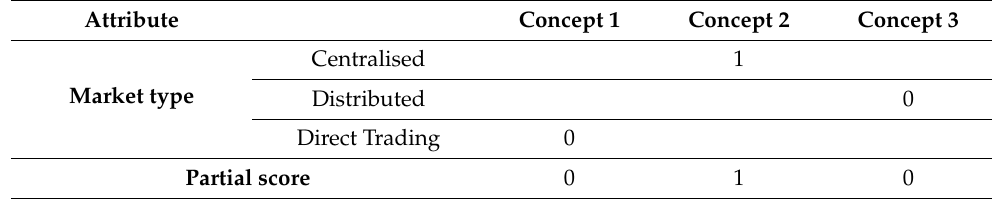
Table 16. Scalability potential—second partial score. Market type